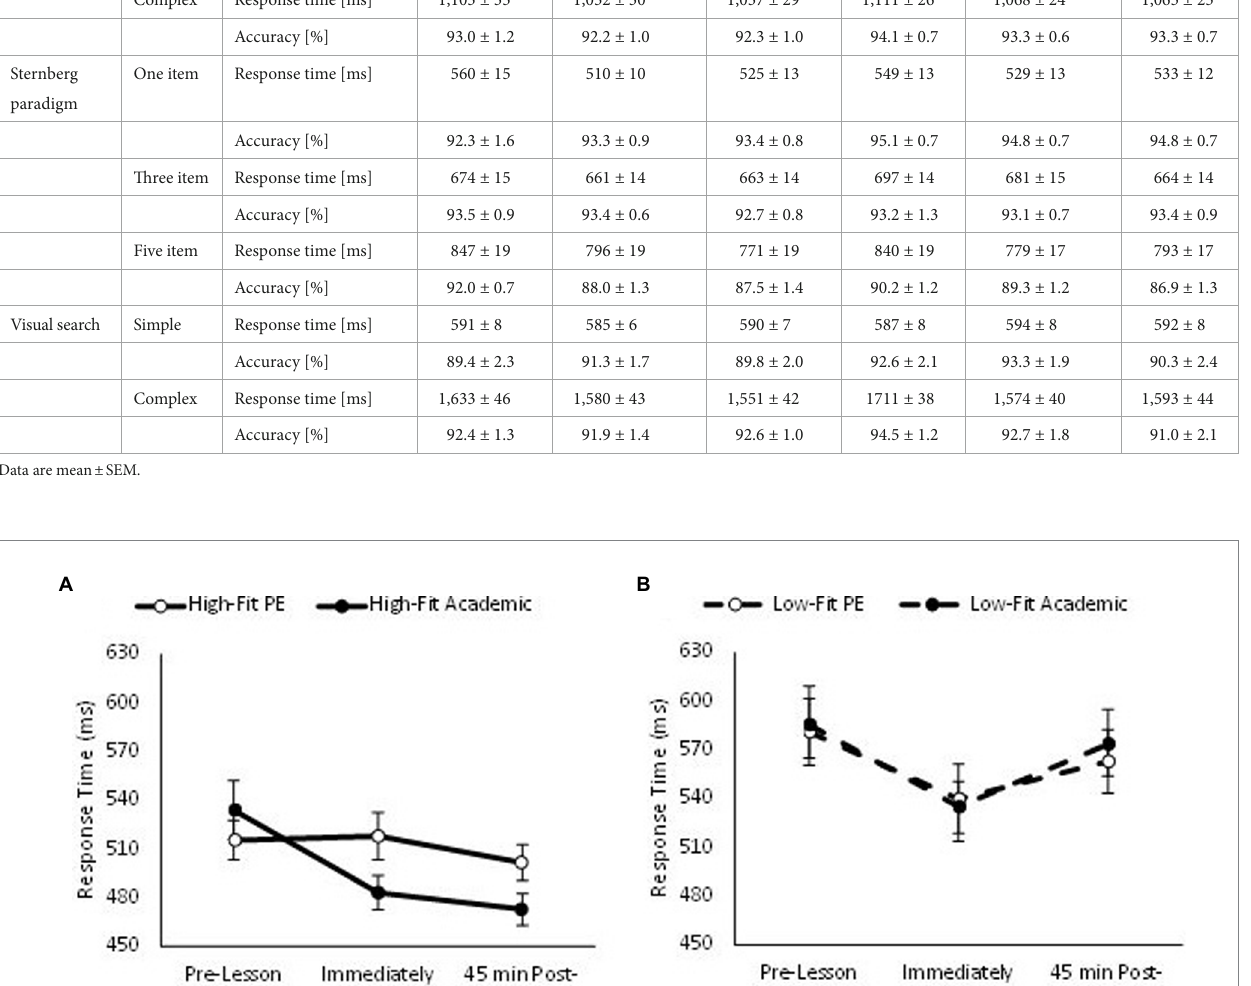
trial, F (1,74) = 13.07, p = 0.001, partial η 2 = 0.041) and got quicker across the morning (main effect of time, F (2,148) = 10.13, p < 0.001, partial η 2 = 0.044). Response times on the three item level of the Sternberg